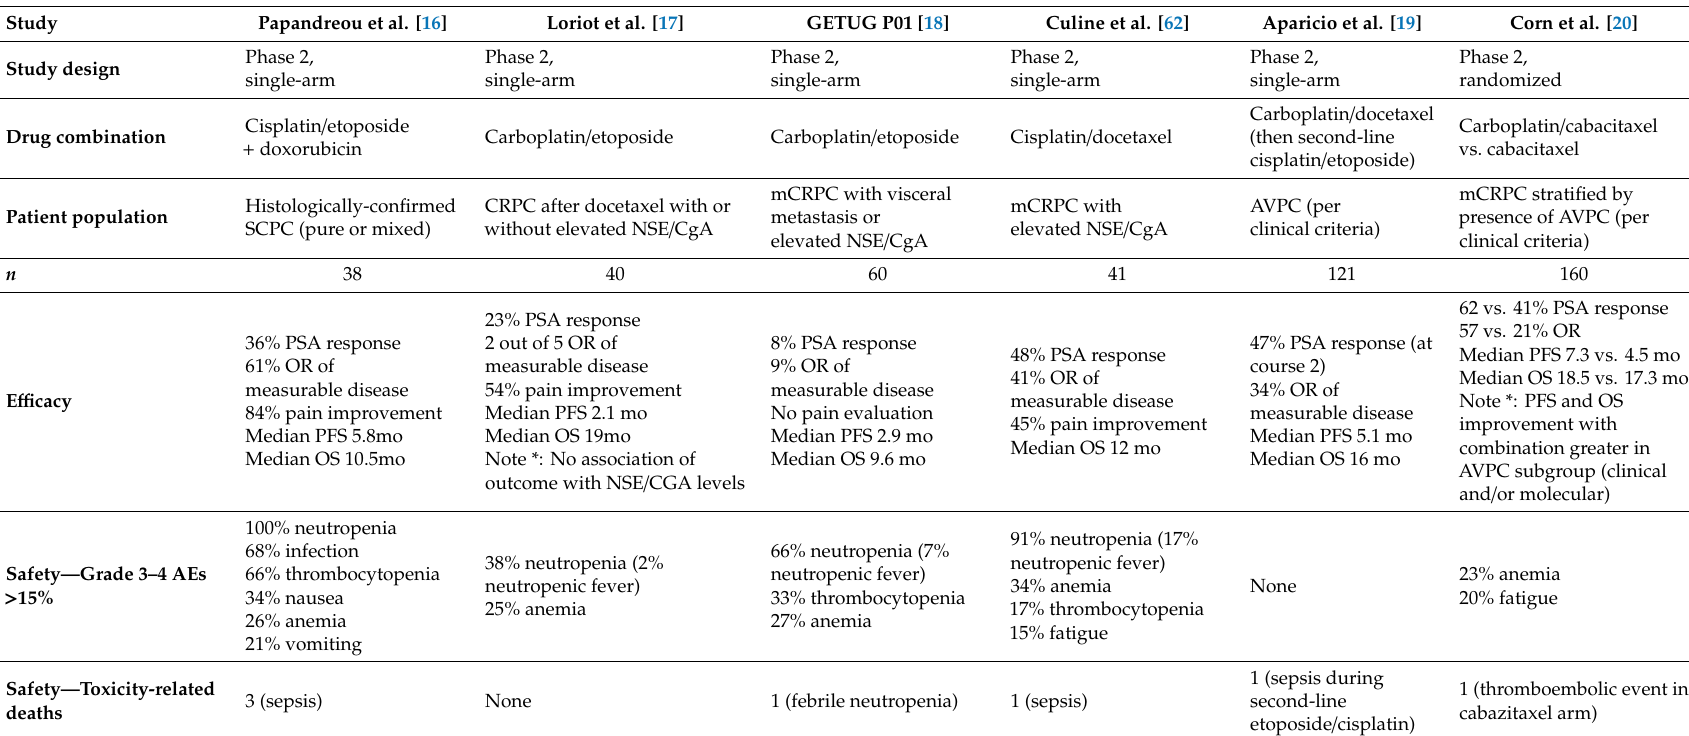
Table 3. Chemotherapy trials in aggressive-variant prostate cancer